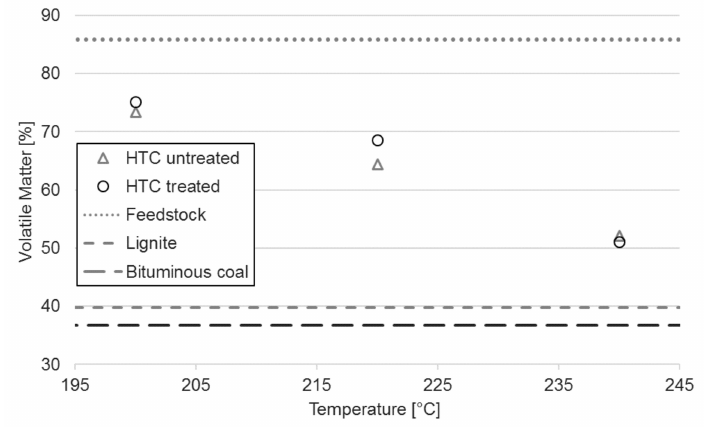
Figure 5. Volatile matter of hydrochar samples as a function of reaction temperature for untreated and treated wood.